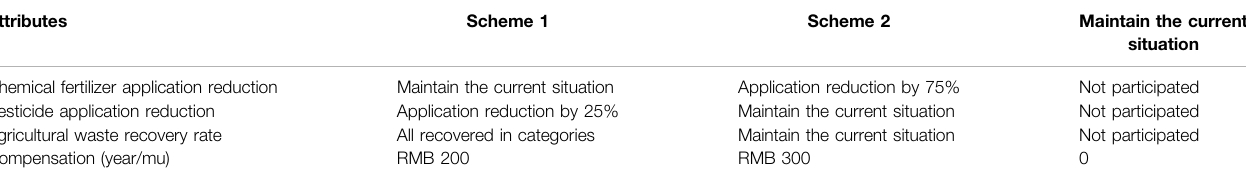
TABLE 2 | Examples of selection cards in selecting experiment.